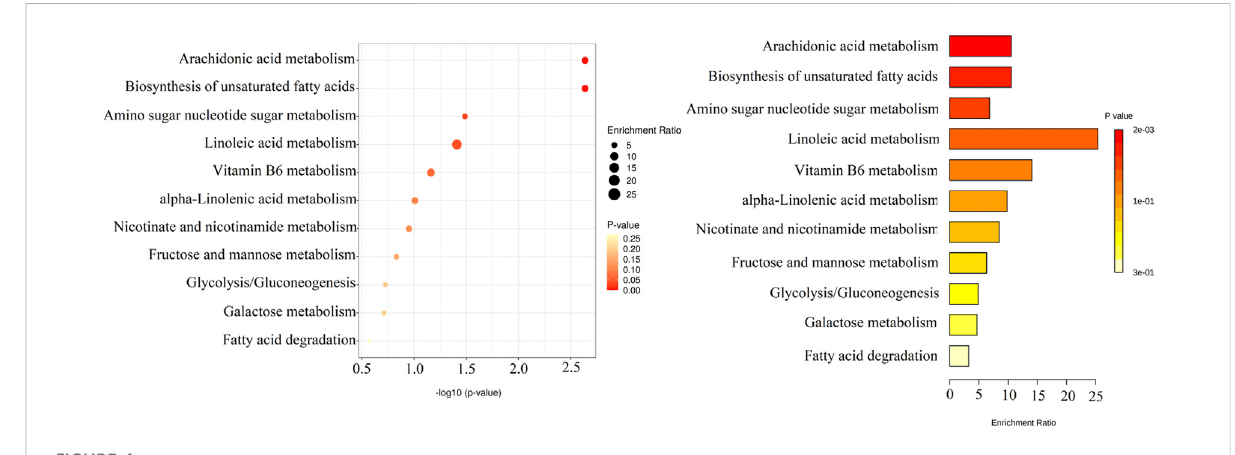
FIGURE 4 KEGG enrichment pathways of 13 differential